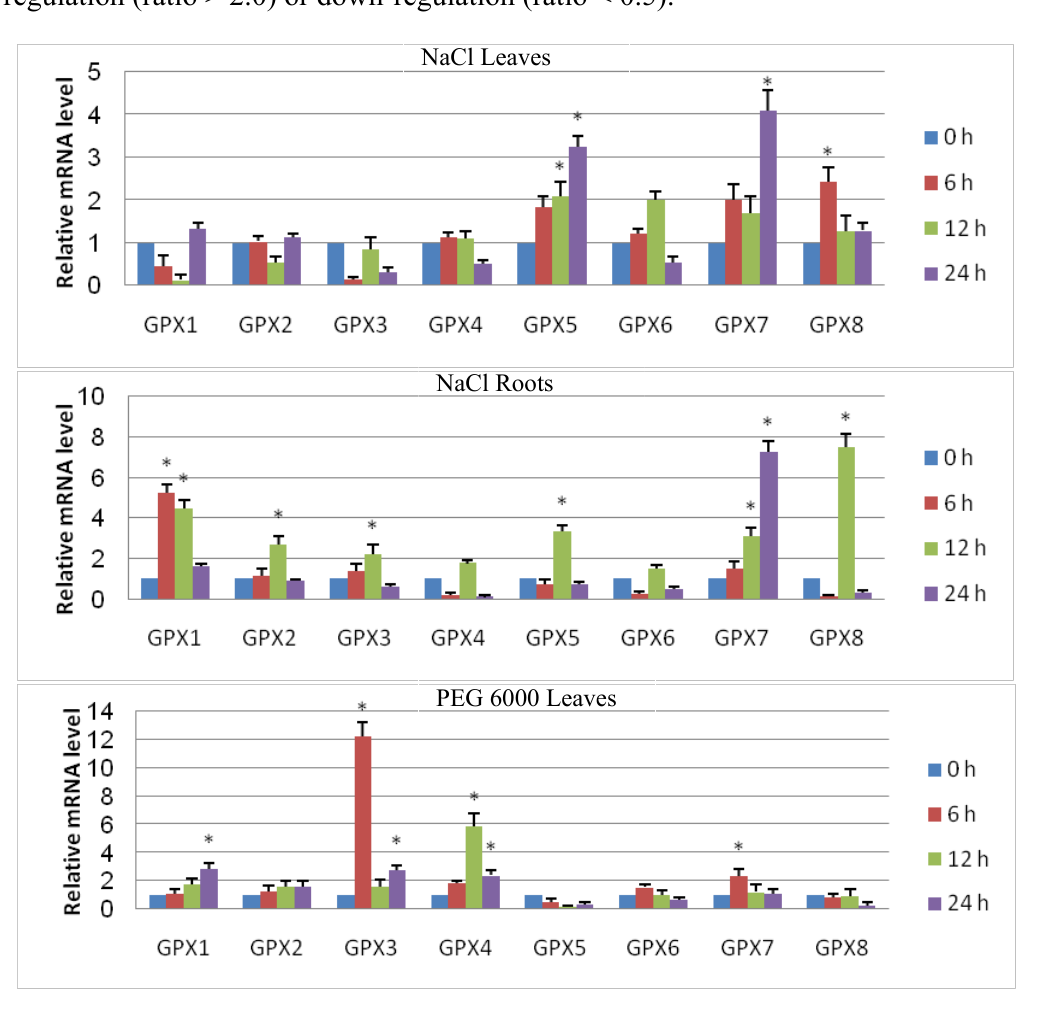
Figure 4. Time-course expression analysis of Thellungiella salsuginea glutathione peroxidase ( TsGPX ) genes in leaves or roots of T. salsuginea exposed to NaCl (300 mM) or PEG 6000 (20%). mRNA levels were normalized with respect to TsTubulin and are expressed relative to the values at 0 h (control), which were given an arbitrary value of 1. Data represent the means ± SE of at least three replicates. Asterisks denote significant up-regulation (ratio > 2.0) or down-regulation (ratio <